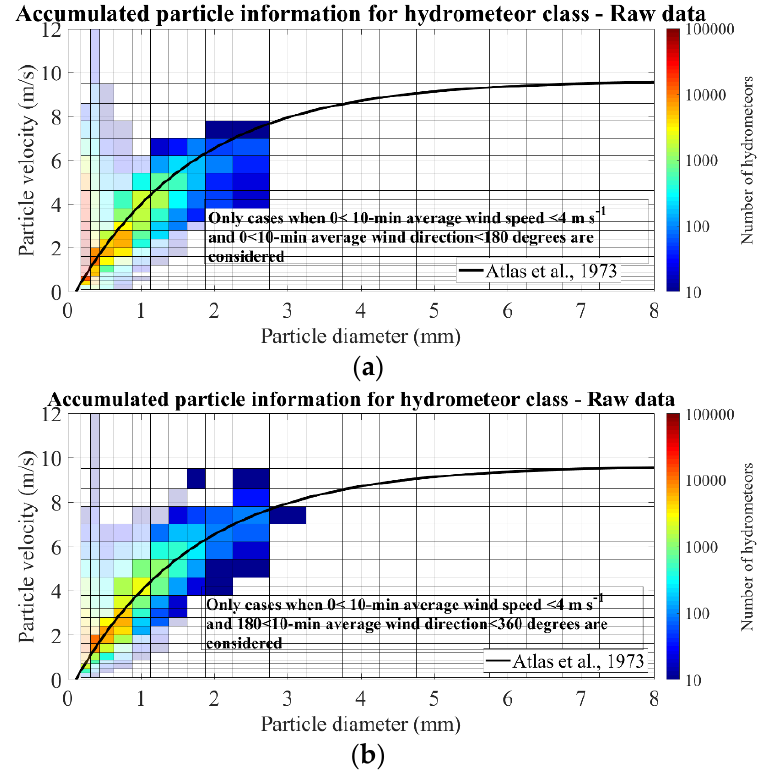
Figure 11. Aggregated Thies spectrograph in high turbulence intensity conditions for average wind speed ranging from 0 to 4 m s − 1 . In panel ( a ), only cases with wind direction ranging from 0 to 180 degrees are considered, whereas panel ( b ) takes into account only cases with direction between 180 and 360 degrees. The color scale indicates the number of drops in each size-velocity class and de- viation larger than 50% from theoretical drop size-velocity relationship are indicated in transpar- encies. The empirical relationship between raindrop diameter and fall velocity proposed by [33] is highlighted as black curve.